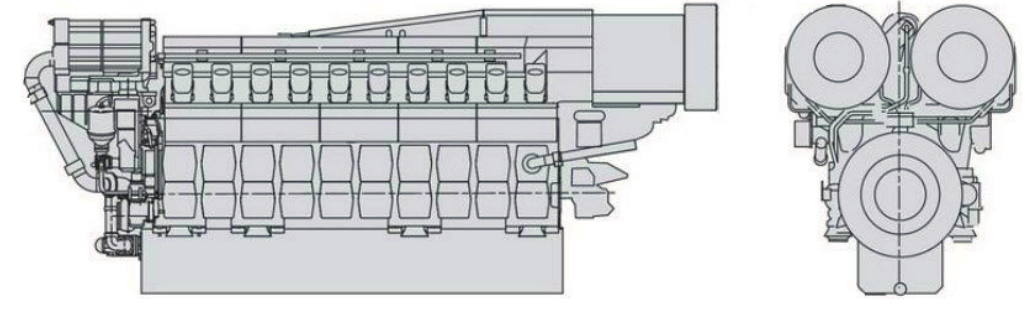
Figure 5. Large power marine diesel engine.